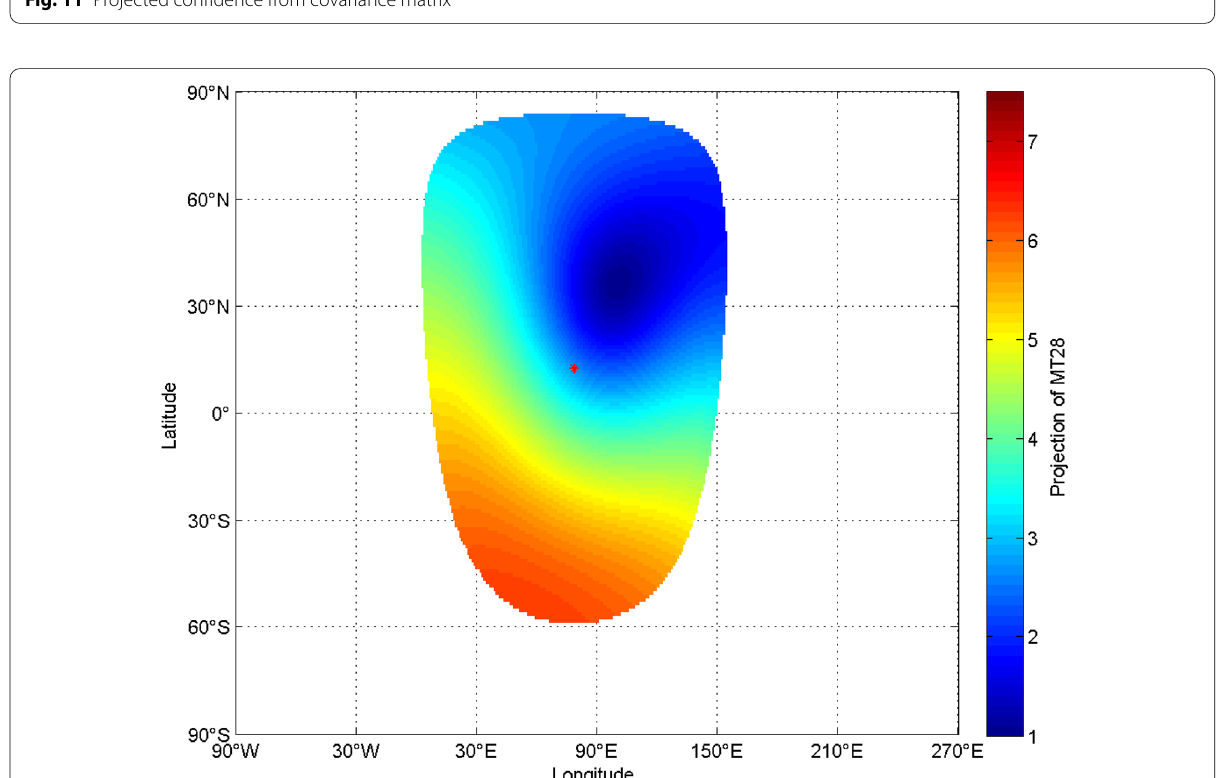
Fig. 12 Projected confidence according to